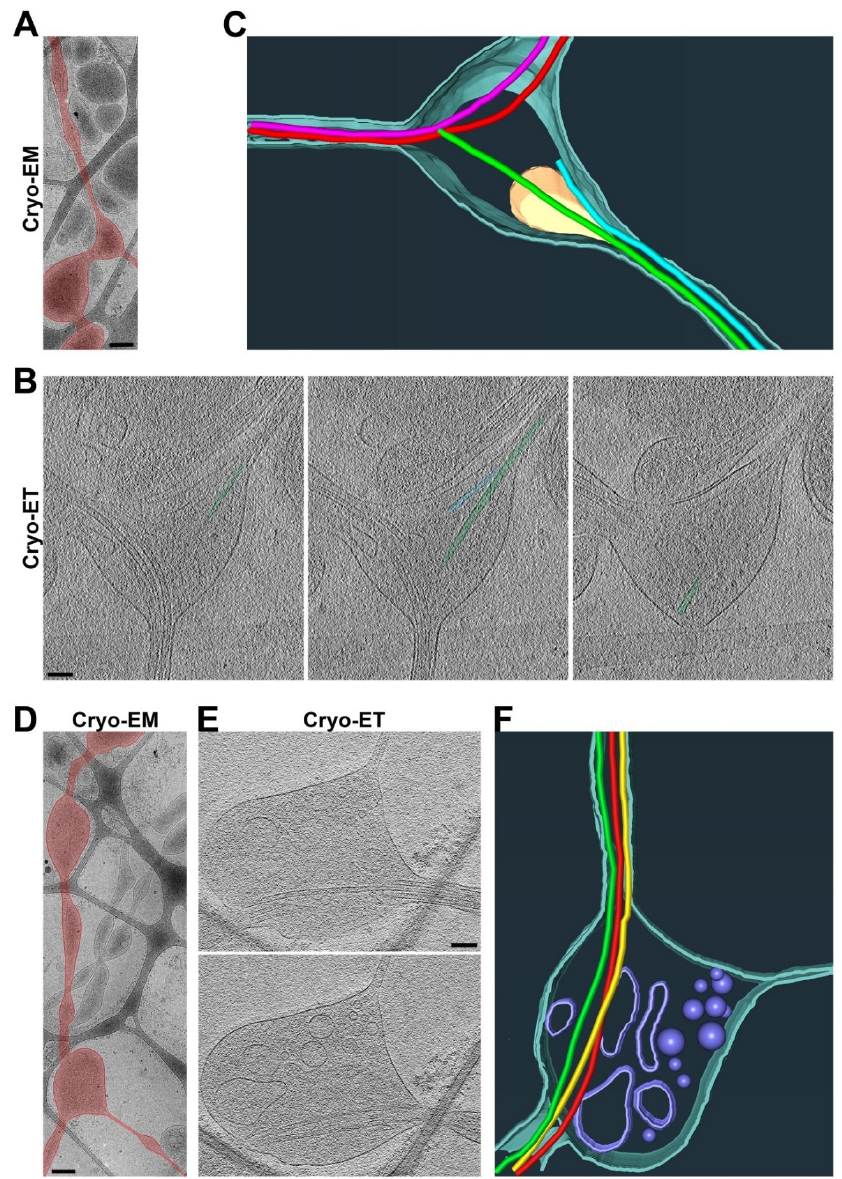
Figure 5. Three-dimensional ultrastructures of two typical types of axon branch points. ( A ) Low- magnification Cryo-EM image of an axon and its branch point. An axon with a branch point is high- lighted in red. ( B ) Three slices from the Cryo-ET tomogram of the axon branch point in ( A ). De novo formation of two MTs and their free ends for one branch are highlighted in green and cyan. ( C ) Segmentation view of the branch point in ( B ). Two MTs in red extending into one of the two daugh- ter branches. Two MTs formed de novo within the branch point (one in green and the other in light